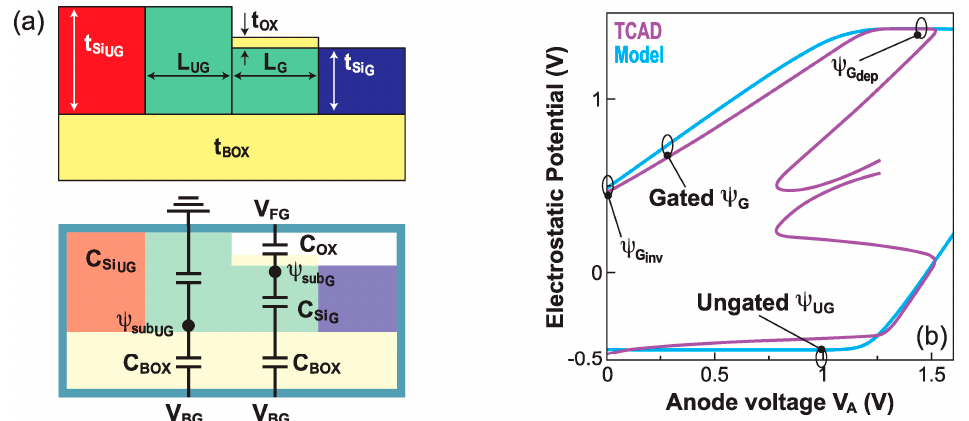
Figure 11. ( a ) Definition of the Z 2 –FET electrical parameters and equivalent capacitor circuit. ( b ) Electrostatic potential in gated and ungated regions vs. anode voltage in the OFF and barrier-collapsing (BC) regimes; the results derived from the model and TCAD are in good agreement (adapted from [29]).